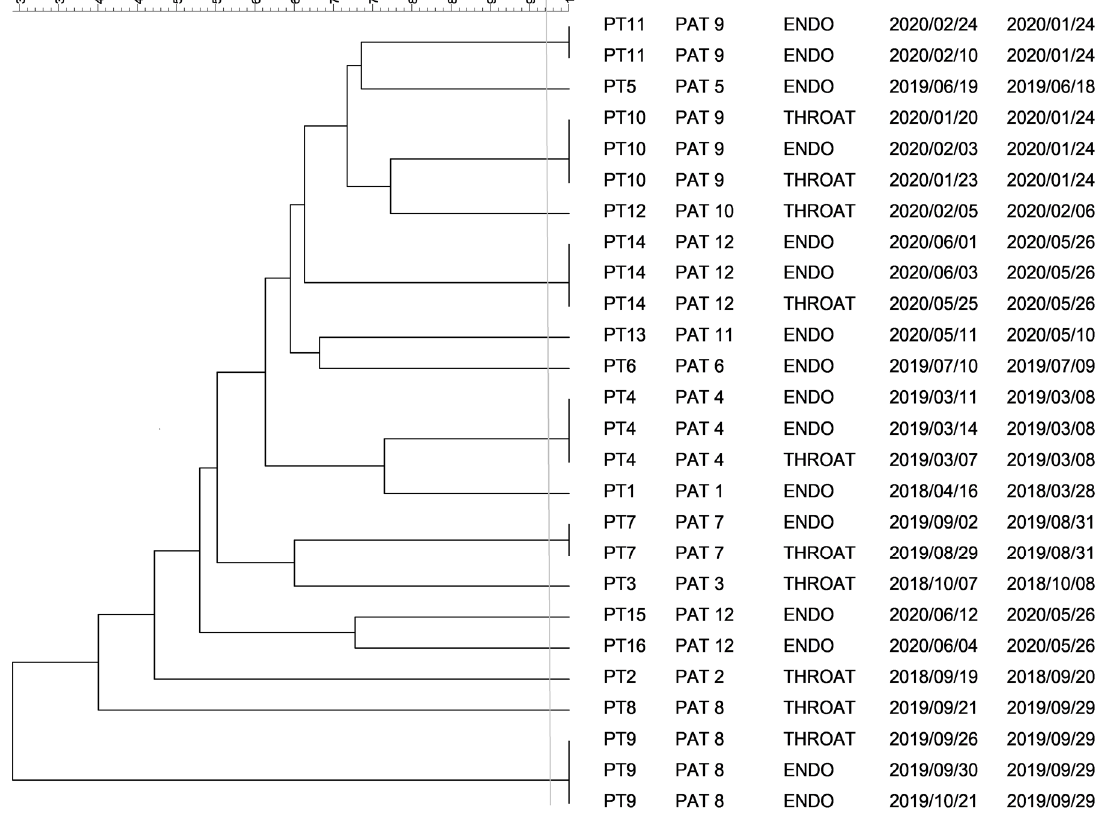
Figure 1. Dendrogram for restriction patterns of K. pneumoniae isolates. Legend: horizontal axis—similarity of isolates (%); vertical axis—pulsotype, patient code, type of sample, date of sample collection, date of VAP diagnosis; PT pulsotype, PAT patient, ENDO endotracheal aspirate sample, THROAT throat swab. The vertical line indicates the similarity threshold set at 97%.